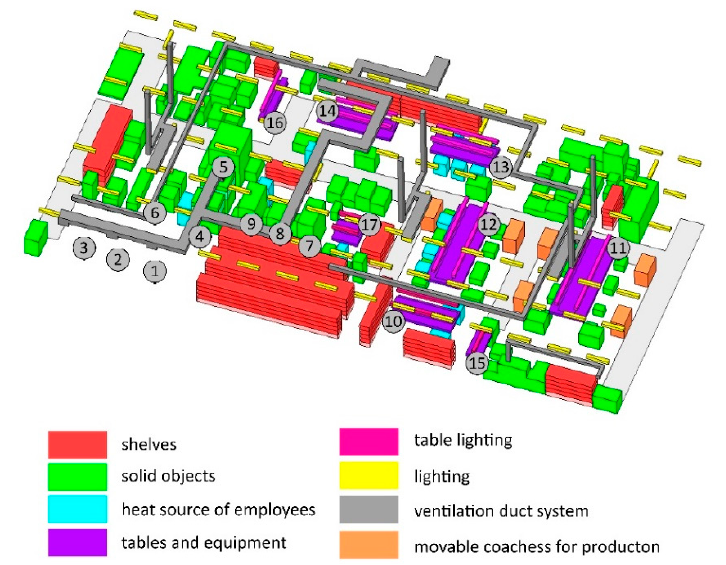
Figure 8. Internal heat gains from occupants, equipment and artificial lighting in the production hall.